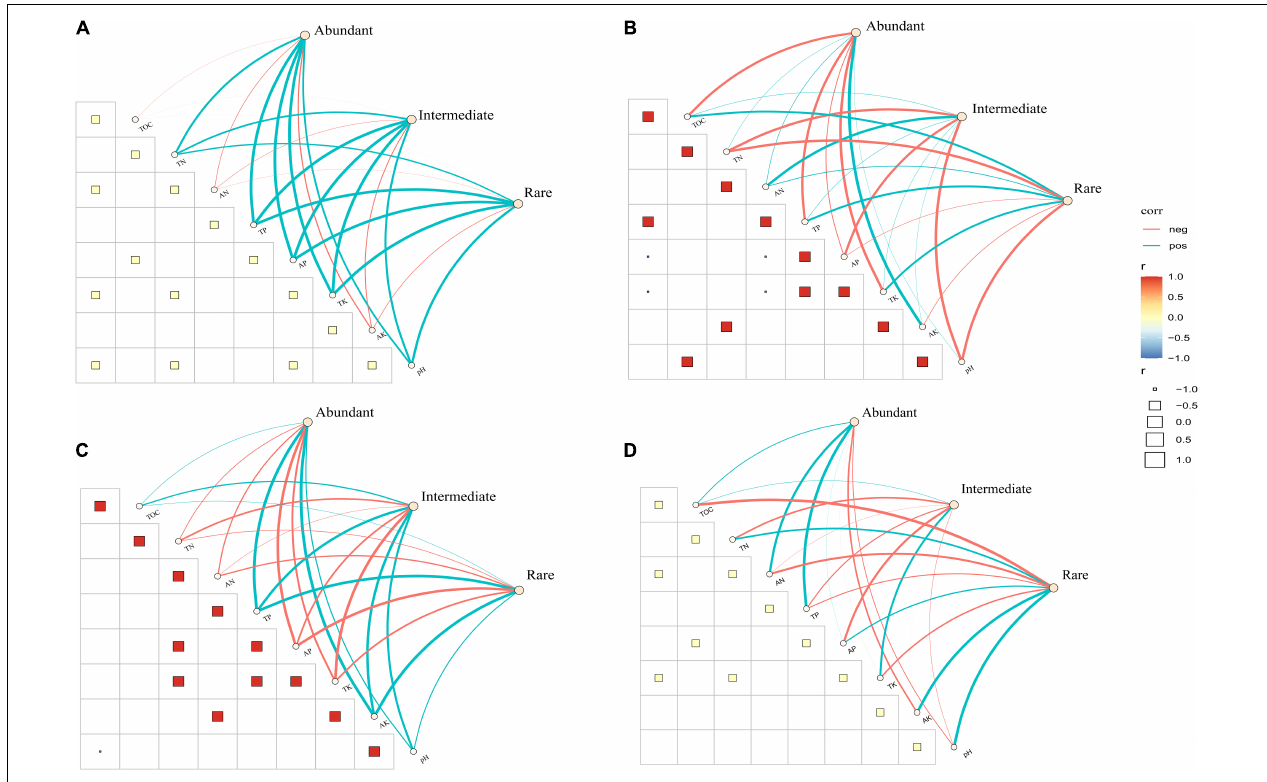
FIGURE 4 | Pairwise comparisons of soil properties and their effects on fungal sub-communities composition in four treatments, with a color gradient denoting Spearman’s correlation coefficients. Edges represent Mantel’s r for correlations, and the color corresponding to the significance. (A) CT. (B) CTS. (C) NT. (D)